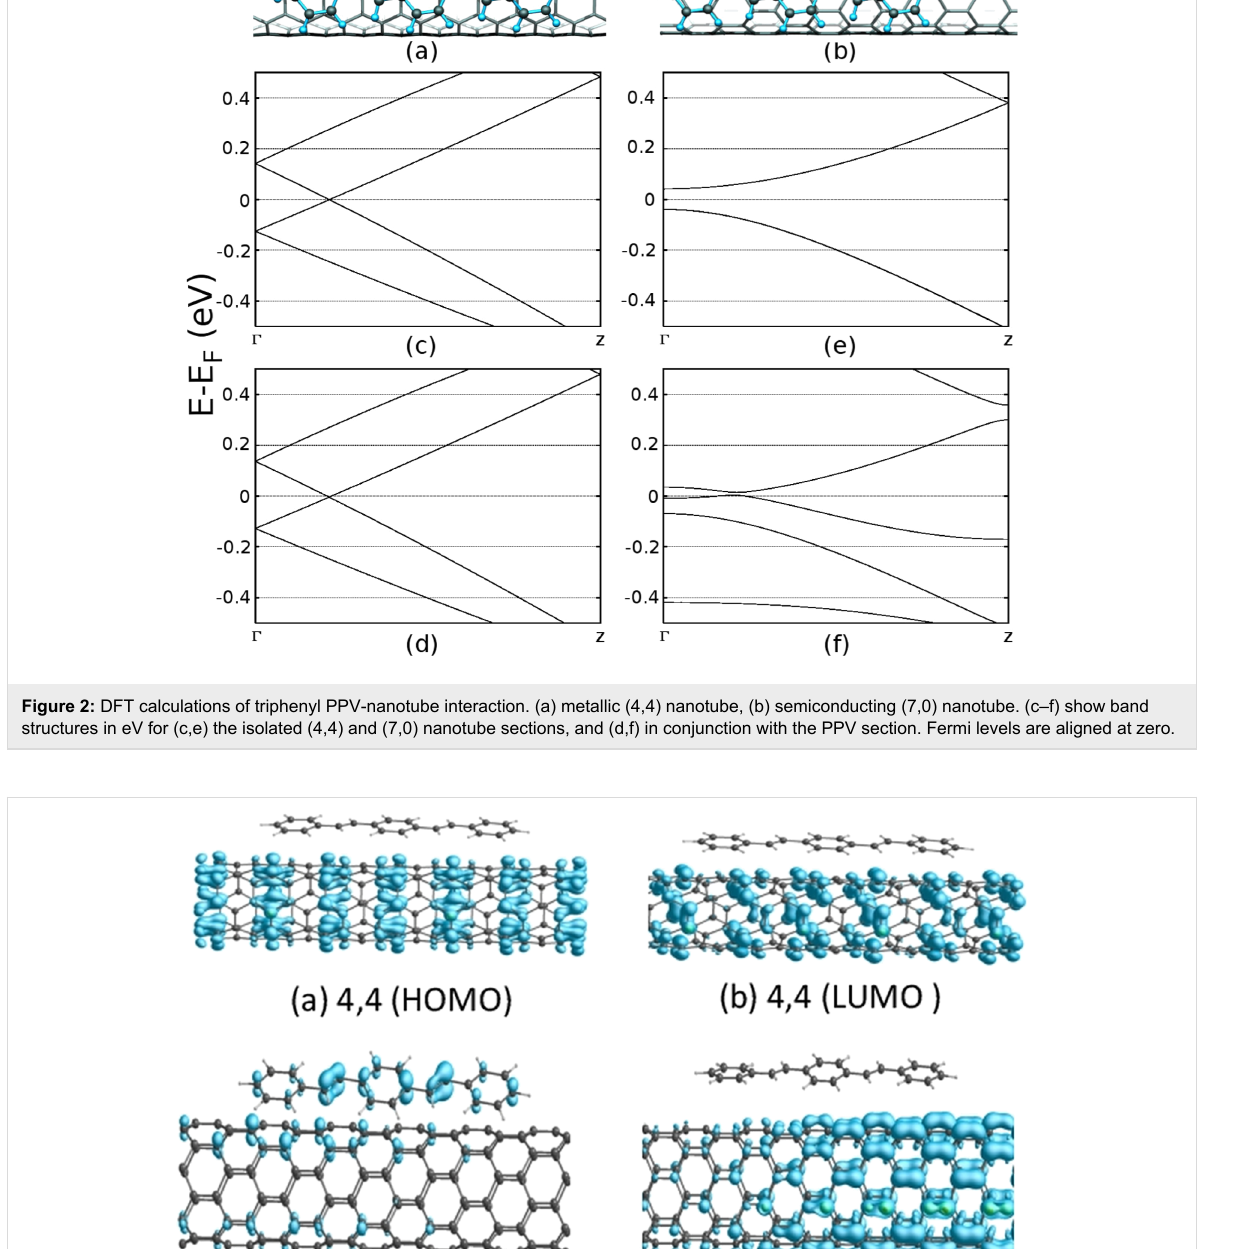
junctions. The time-resolved PL data taken on the composites are presented in Figure 4a. The high-energy PL band at 2.41 eV, labelled 1, gains intensity with respect to the other lines at 2.26 eV and 2.10 eV (labelled 2 and 3) at high mass percent-